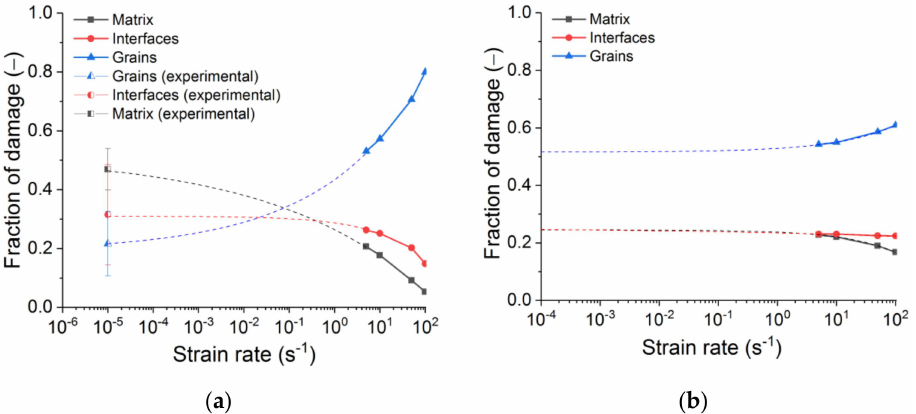
Figure 16. The dependences of the contributions of constituents to the fracture of refractory samples on the strain rate: tension (supplemented by experimental data) ( a ) and compression ( b